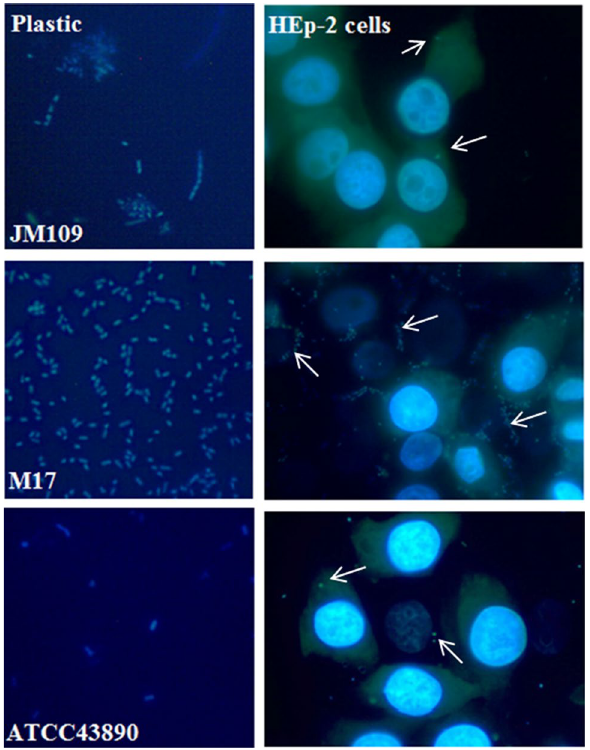
Figure 7. The microphotographs of adhered E. coli strains. Arrows show the adhered bacteria on specific locations of cell